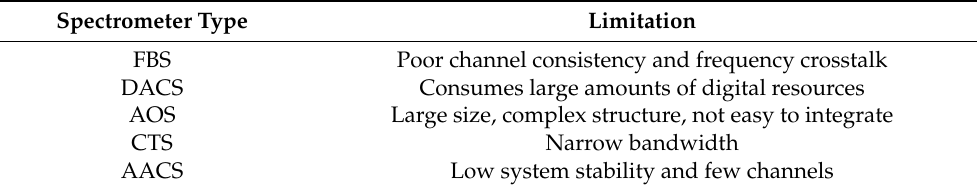
Table 1. Limitations of the spectrometers used in